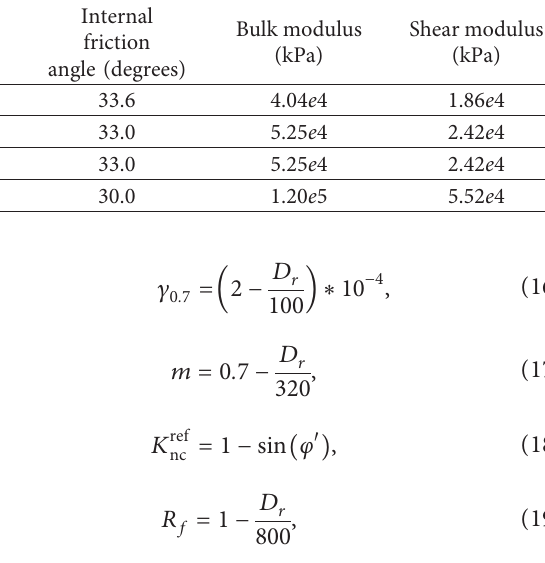
Table 2: The thickness of soil layers and the soil